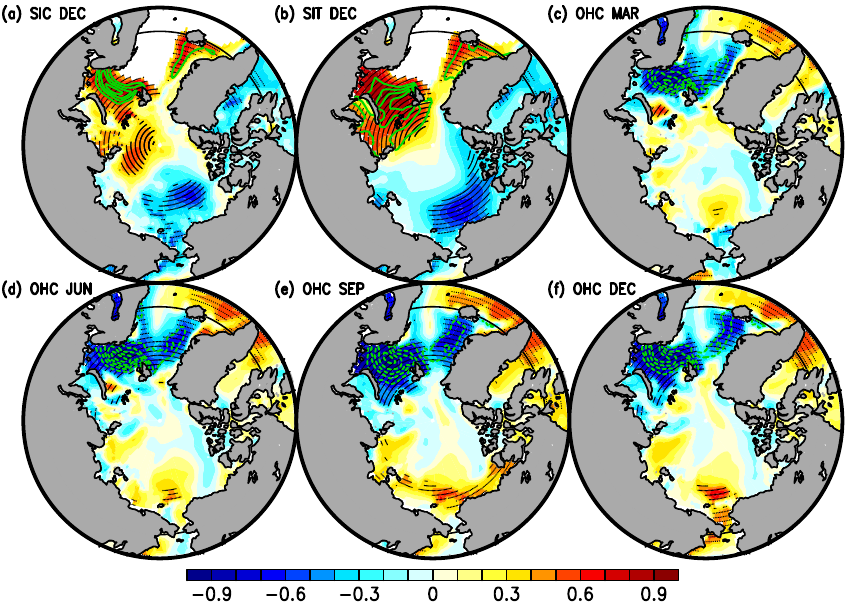
Figure 4. Lagged correlation (colours) and regression (contours) coefficients between the SIE AO anomaly ( × 10 6 km 2 ) in December and (a) SIC anomaly (%) at a lag of 0 months, (b) SIT anomaly (cm) at a lag of 0 months, and OHC anomalies ( × 10 18 J) at lags of (c) − 9, (d) − 6, (e) − 3, and (f) 0 months, in regions from 60 to 90 ◦ N on the basis of the hindcasts started from 1 January. Contours are drawn at intervals of 5 (%) from 5 to 25 for SIC and 10 (cm) from 10 to 40 for SIT. In (c–f) , the contours are drawn from − 1.0 to − 0.1 ( × 10 18 J) at intervals of 0.1 ( × 10 18 J). Stippling indicates regions with statistically significant correlation coefficients at the 95% confidence level. White shading indicates areas where sea ice does not exist. A latitude circle of 65 ◦ N is also indicated by a thin solid line.